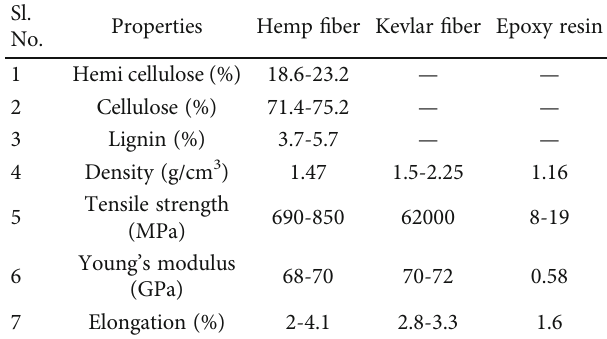
Table 1: Mechanical properties of reinforcements and matrix.